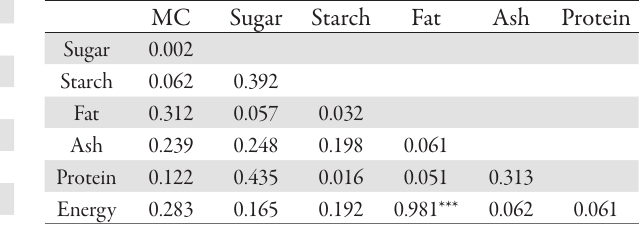
Tab. 5. Pearson correlation of coefficients among the